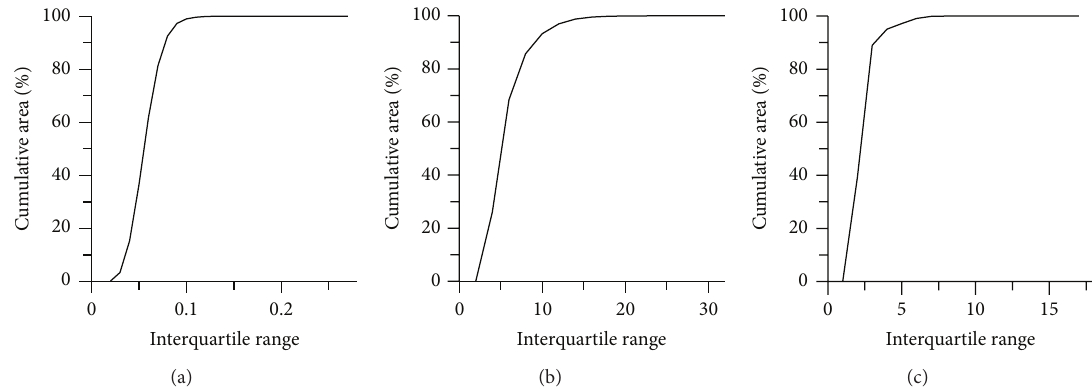
Figure 9: Covered cumulative area percentage in dependence of the interquartile range. (a) Occurrence probability of stagnic properties, (b) stagnic layer thickness, and (c) organic layer